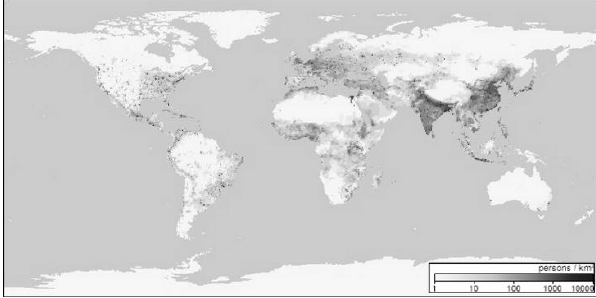
Figure 9. World population density (updated to 2000) [34].